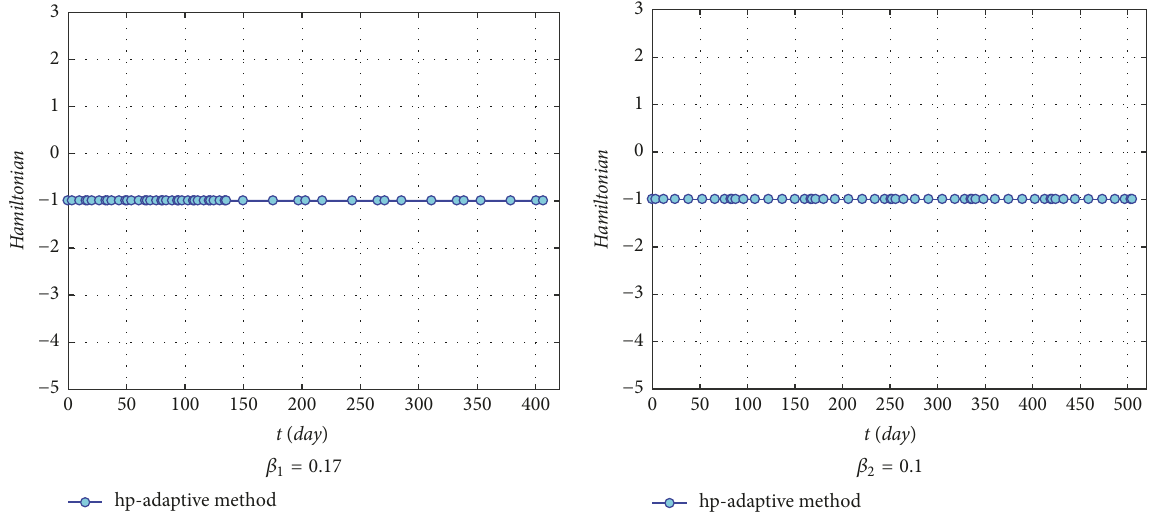
Figure 10: The curve of